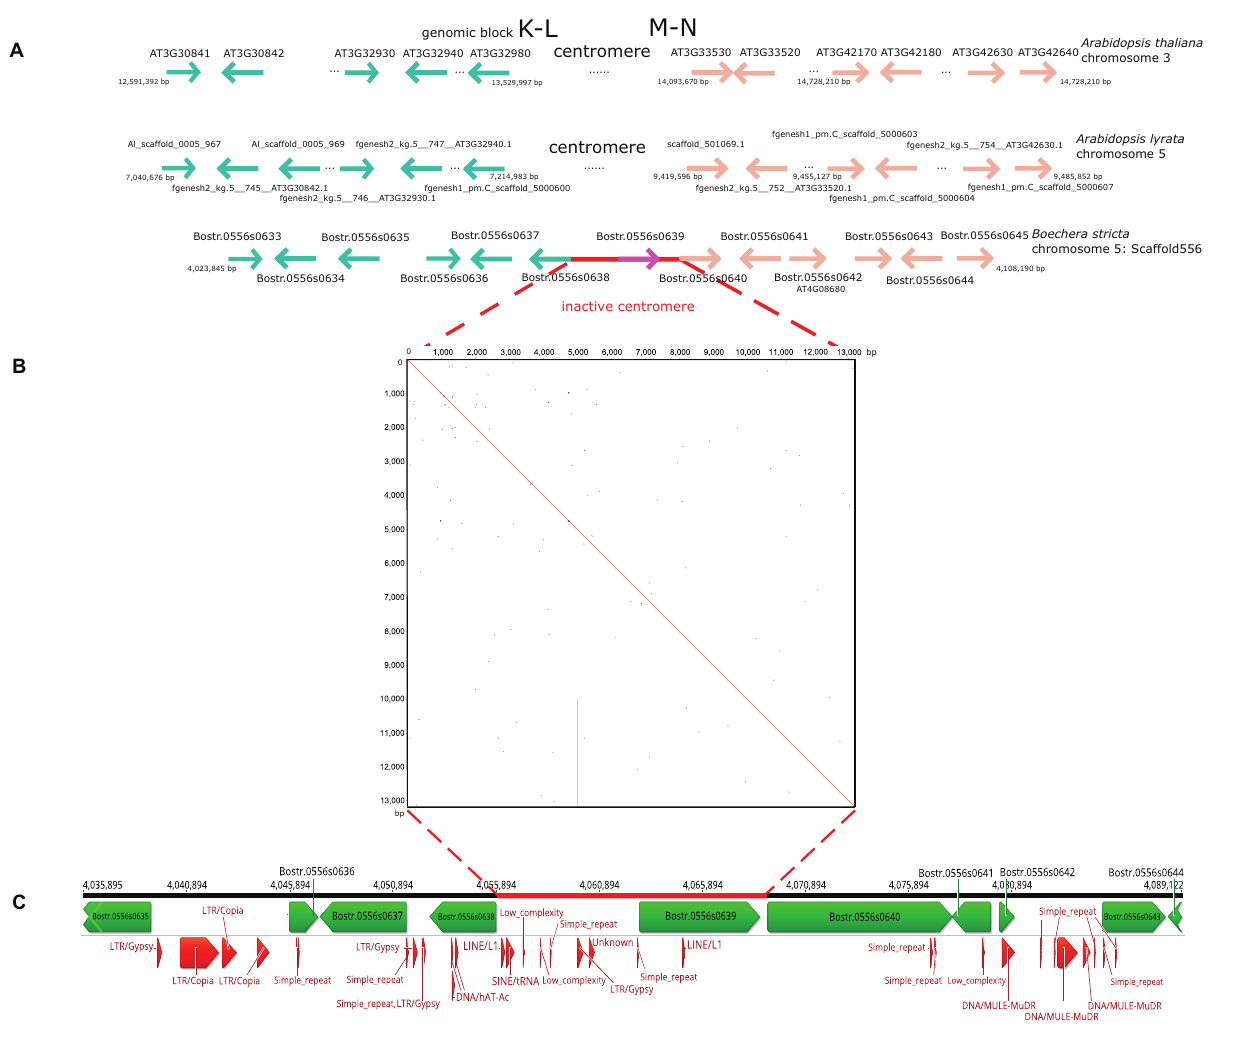
FIGURE 7 | Sequence comparison of the AK5 centromeric region on homeologous chromosomes in Arabidopsis thaliana , A. lyrata and Boechera stricta . (A) The functional centromere on chromosome 3 and 5 in A. thaliana and A. lyrata , respectively, is located between genomic blocks K-L and M-N, between At3g32980 and At3g33530. The 13-kb region corresponding to the inactive AK5 centromere is located between genes Bostr.0556s0638 and Bostr.0556s0640 on chromosome Boe5. (B) A dot-plot self-comparison of the 13-kb region on Boe5 showing the absence of tandem repeat arrays. (C) Annotation of the B. stricta scaffold 556 including the 13-kb region and regions 20 kb upstream and downstream. Transposable elements and their remnants do not exhibit a higher abundance within the 13-kb